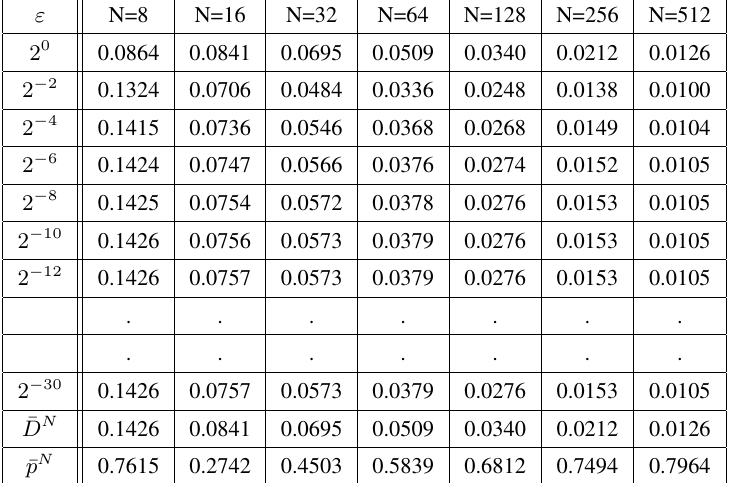
T WO MESH GLOBAL DIFFERENCES PARAMETER - UNIFORM TWO MESH DIFFERENCES AND GLOBAL ORDERS OF PARAMETER - UNIFORM CONVERGENCE FOR THE DISCRETE DERIVATIVE D − U ε